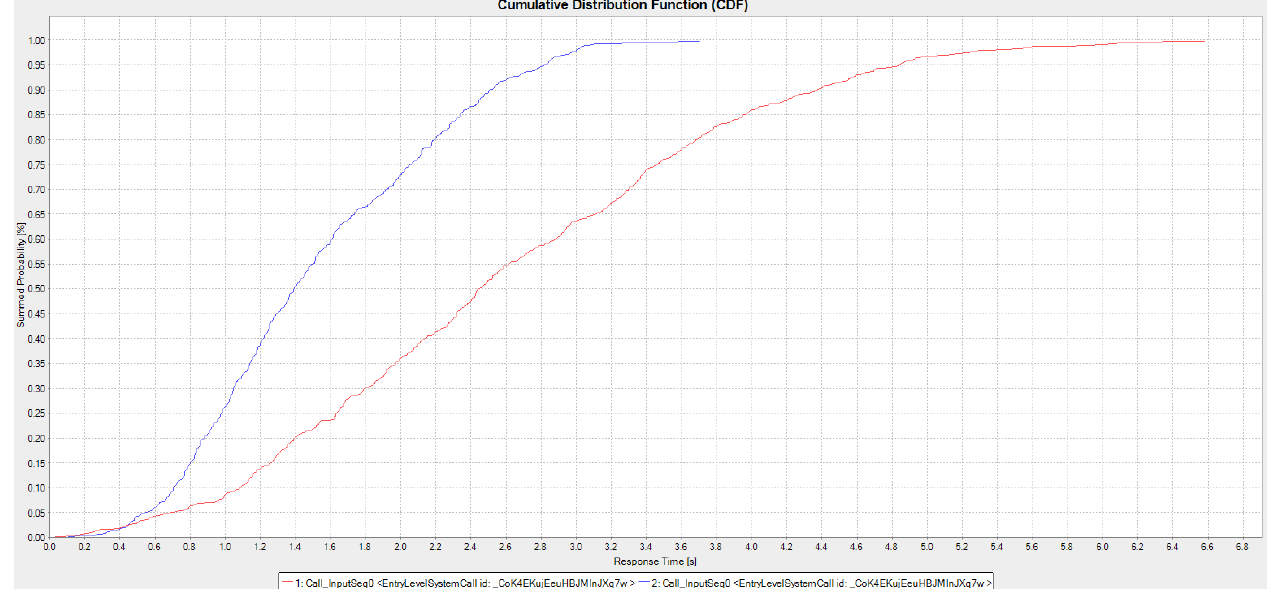
Figure 11. Comparison between the response time of the passInput function from the original architecture (red curve) and the alternative design (blue curve) .